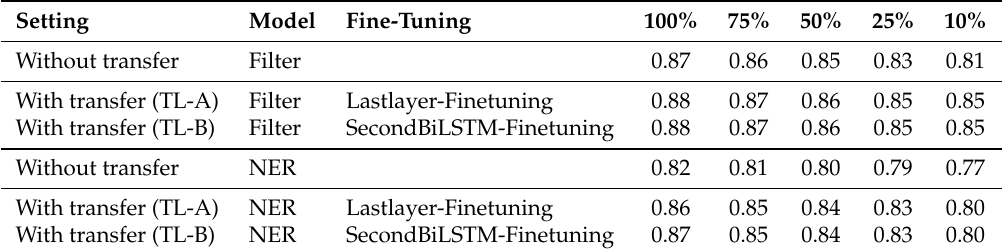
Table 6. Invoice date to expiration date : F1 score of recognition of expiration date in the test set by transfer learning from a base model trained with invoice date labels. Results at different levels of freezing trained with different percentages of labeled target data are presented.